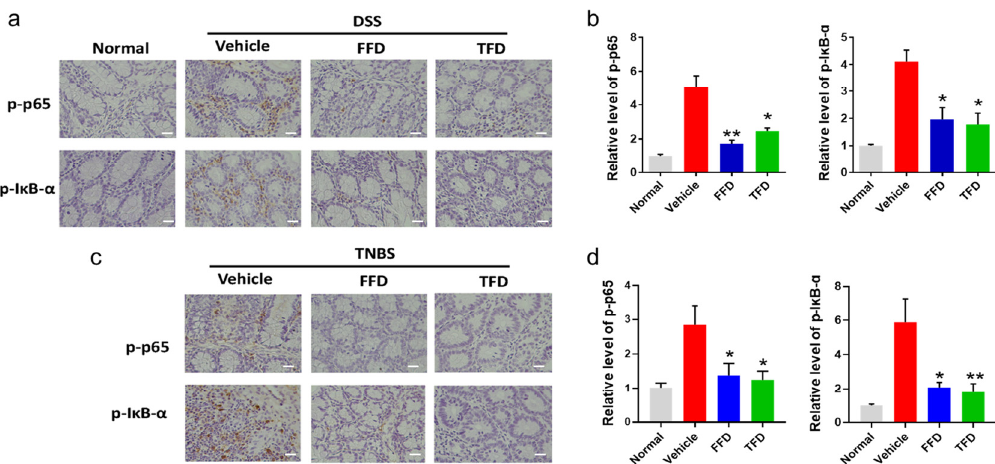
Figure 4. Immunohistochemistry (IHC) analysis of p-p65 and p-I κ B- α in colon tissues. ( a ) IHC staining of p-p65 and p-I κ B- α in paraffin-embedded samples collected from DSS model mice. ( b ) Statistical analysis of a. ( c ) IHC staining of p-p65 and p-I κ B- α in paraffin-embedded samples collected from TNBS model mice. ( d ) Statistical analysis of c. Terfenadine and Fexofenadine are indicated with TFD (10 mg/kg) and FFD (2 mg/kg), respectively. Statistical analysis was done to compare the treatment groups and vehicle groups. n = 6 per group. Data are mean ± SE; * p < 0.05, ** p < 0.01. (Scale bar, 50 µ